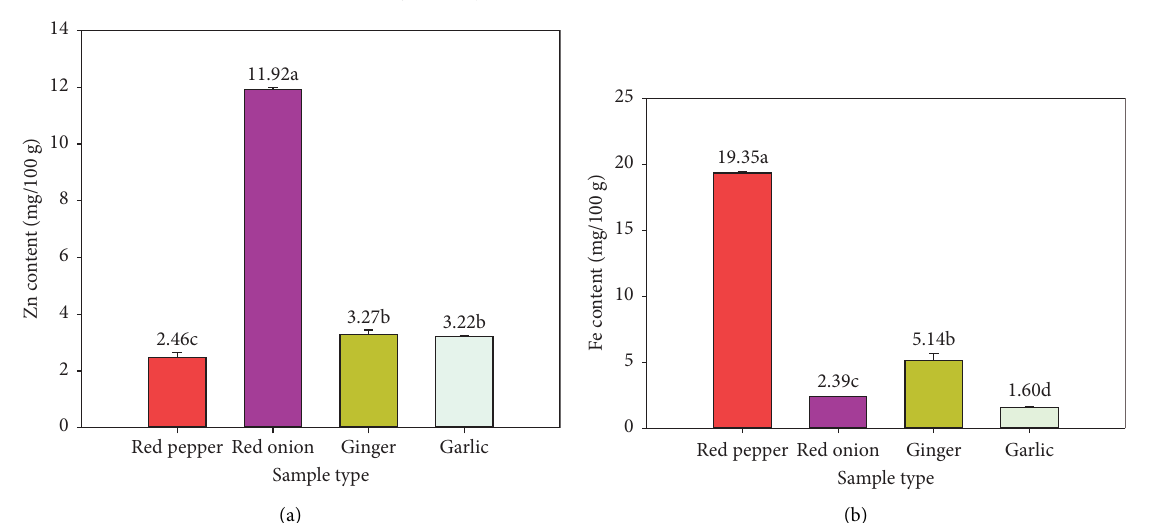
Table 1: Proximate composition of the samples of red pepper, red onion, ginger, and garlic. Parameters